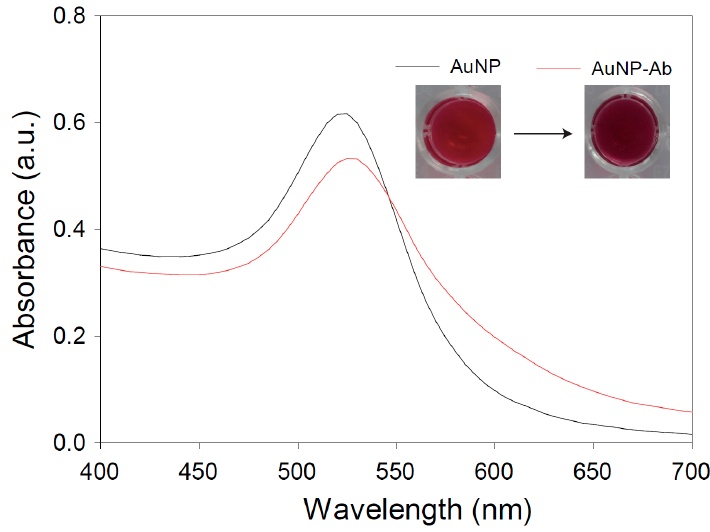
Figure 3. UV-vis spectra of AuNP and AuNP-Ab dispersions.